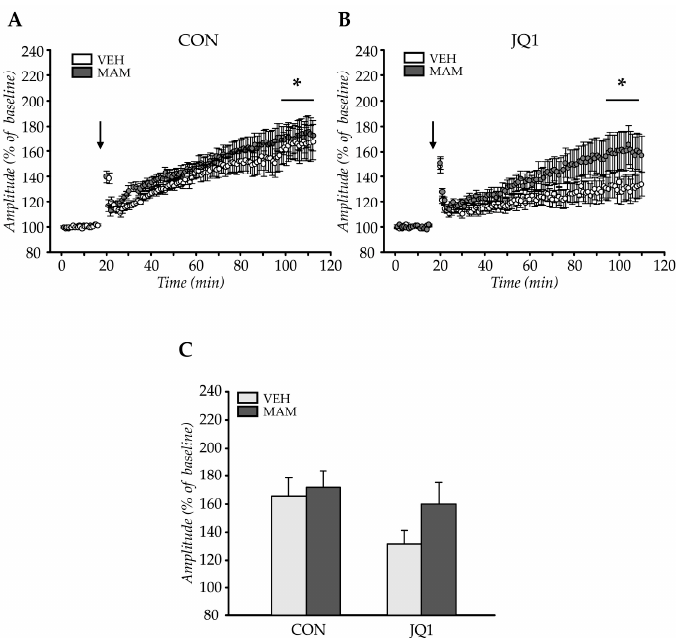
Figure 4. The effects of an adolescent JQ1 administration on long-term potentiation (LTP) in the female adult medial prefrontal cortex in the MAM-E17 model of schizophrenia. The rats were exposed to JQ1 in early adolescence (P23–P29) or vehicle (CON), and the analyses were performed in rats at P60–P110. The data are presented as group mean ± SEM, n = 12–17 (the number of brain sections from 6 to 9 animals). The data are expressed as percentage of the baseline amplitude values for each time point ( A – C ) , C —the average of LTP during the last 15 min of recording. * p < 0.05 compared with the last 15 min of pre-tetanisation recording (for values averaged over the last 15 min of recording); two-way repeated measures ANOVA ( A , B ) or two-way ANOVA ( C ) followed by a Tukey test. Arrows indicate time of delivery of tetanic stimulation.